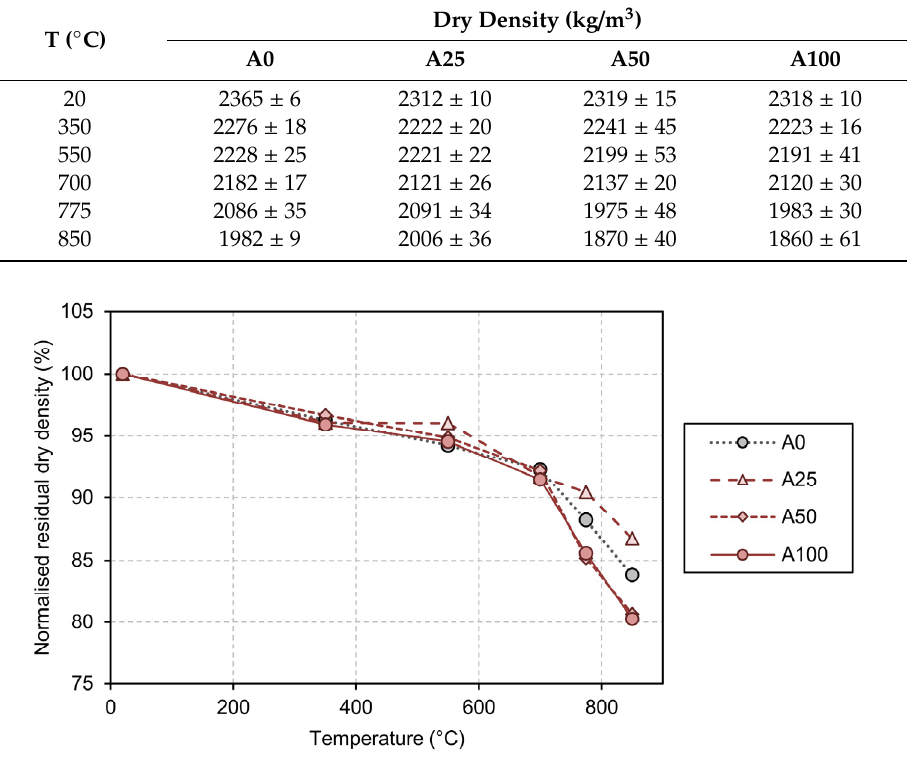
Table 3. Evolution of dry density at high temperatures.